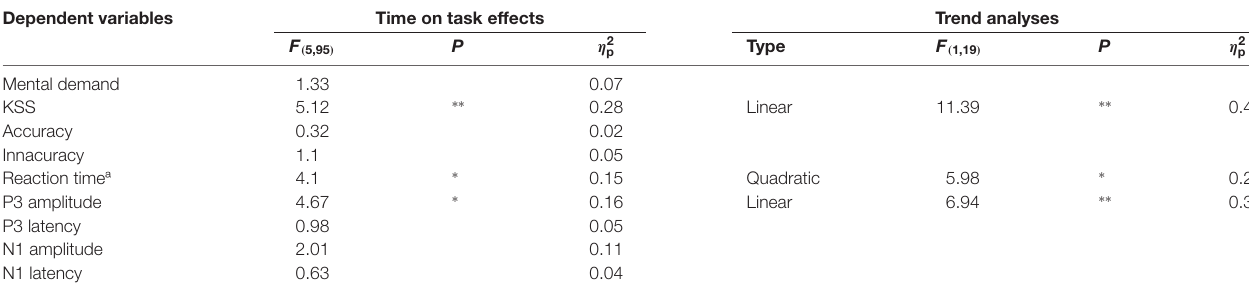
TABLE 2 | Time on task effects and trend analyses for each dependent variable.